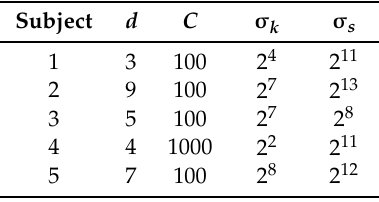
Table 1. Optimal P300 detector parameters for each